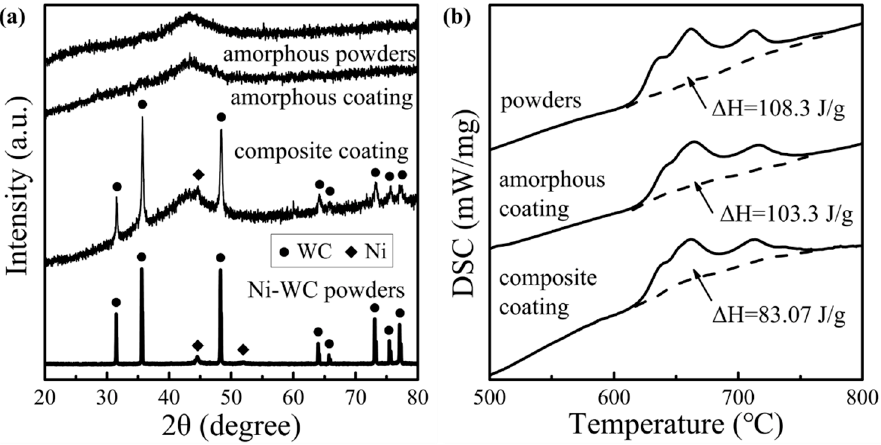
Figure 2. The phase characteristics and thermodynamic analysis of amorphous particles and HVOF coatings: ( a ) the XRD patterns; ( b ) the DSC curves.